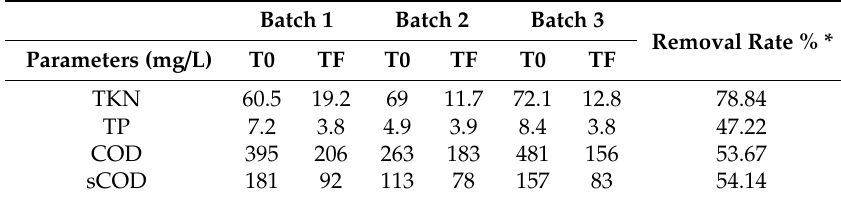
Table 2. Characteristic of influent (T0) / e ffl uent (TF) inoculated with native microalgae using mechanical mixing (MIX) under light / dark (L / D) conditions.